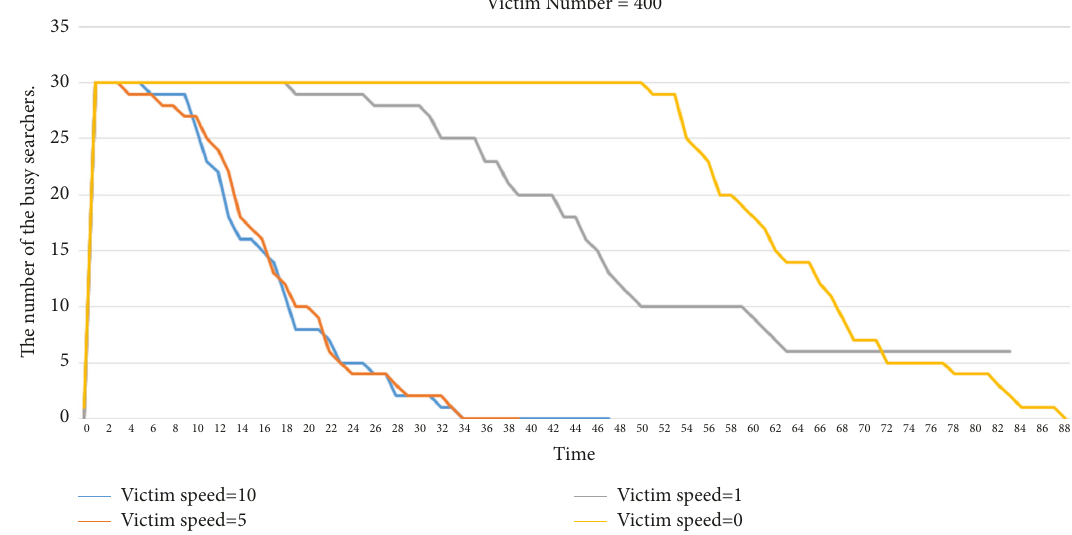
Figure 12: The number of the busy searchers over time (victim number � 400).